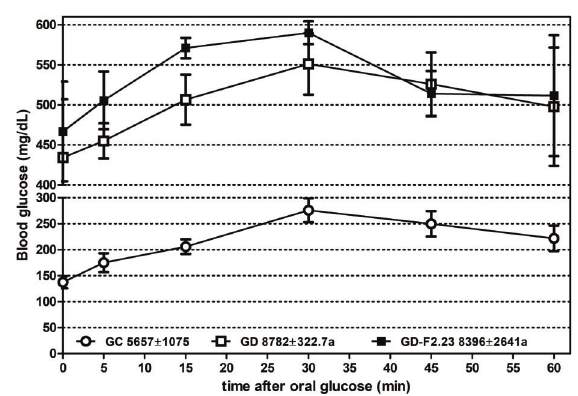
Figure 2. Glucose tolerance test and blood glucose variation of mice from groups GC, GD, and GD-F2.23. GC: control group; GD: diabetic animals; GD-F2.23: diabetic animals that were injected with hydrogel + 2.23 m g/mL phthalocyanine. Data are reported as means ± SD; n=4 – 6/group. a: P o 0.05 vs GC, one-way ANOVA/ Tukey.